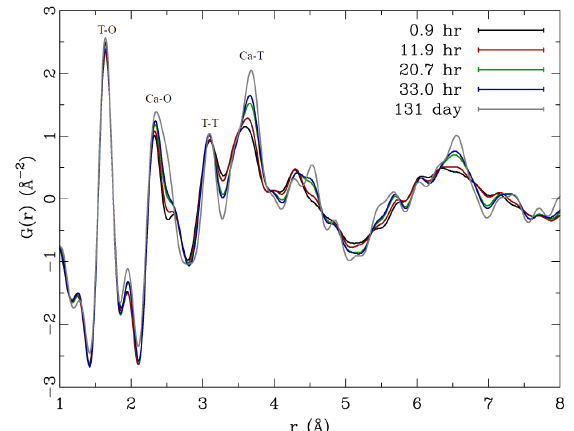
Figure 2. In situ X ‐ ray pair distribution functions of neat alkali ‐ activated slag (AAS) during the formation reaction up to 131 days. Specific atom ‐ atom correlations are labeled including the T ‐ O bond length (were T denotes silicon and aluminum in 4 ‐ fold coordination), Ca ‐ O bond length, and the T ‐ T and Ca ‐ T correlations. Data were collected on beamline 11 ‐ ID ‐ B at the Advanced Photon Source, Argonne National Laboratory. The sample was measured in situ up to 33 hrs, and was re ‐ measured at 131 days on the same beamline. Ref. 9 provides a comprehensive overview of sample synthesis and measurement parameters for this study.